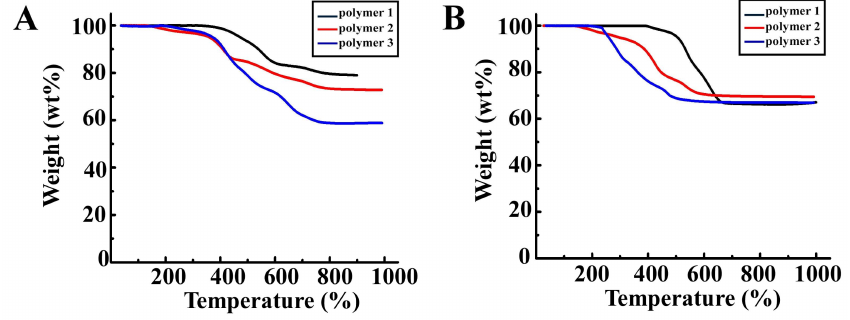
Figure 3. TGA plots of the polymer 1 , polymer 2 and polymer 3 under the N 2 ( A ) and air ( B ) atmosphere